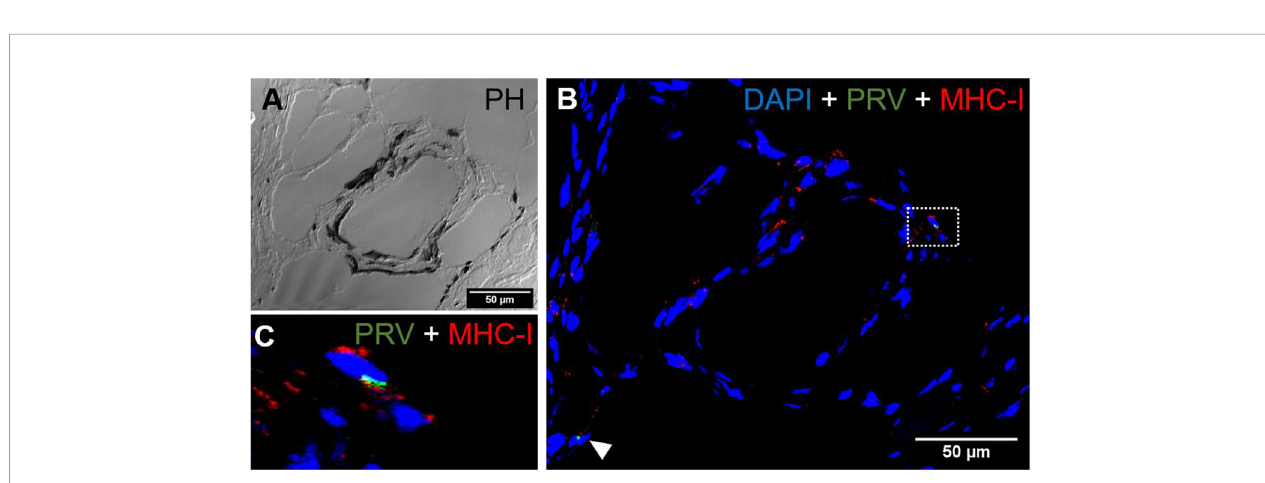
FIGURE 10 | Fluorescent in situ hybridization of PRV-1 and MHC-I in black focal changes . (A) phase contrast image showing vacuolar area surrounded by melano- macrophages and other immune cells. (B) Merged image showing presence of numerous MHC-I positive cells (red) where some are co-staining with PRV-1 (green) (dotted rectangle and arrowhead). (C) Magni fi ed area from image B showing co-localization of PRV-1 in some MHC-I cells. Scale Bar = 50 µm.